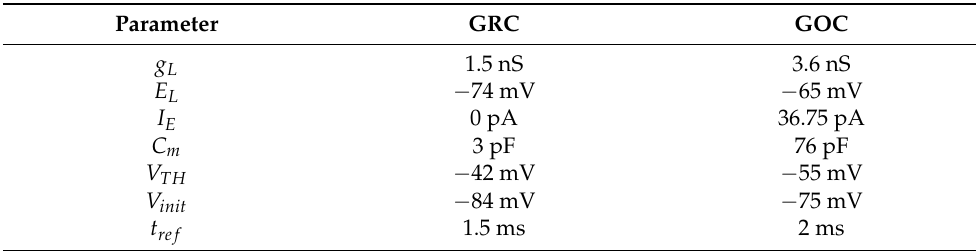
Table 1. LIF models parameters for the GRC and GOC cells.